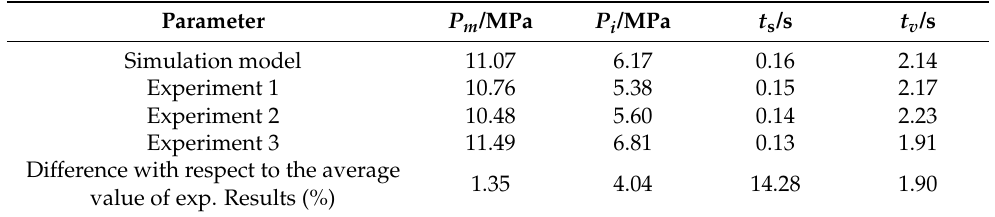
Difference with respect to the average value of exp. Results